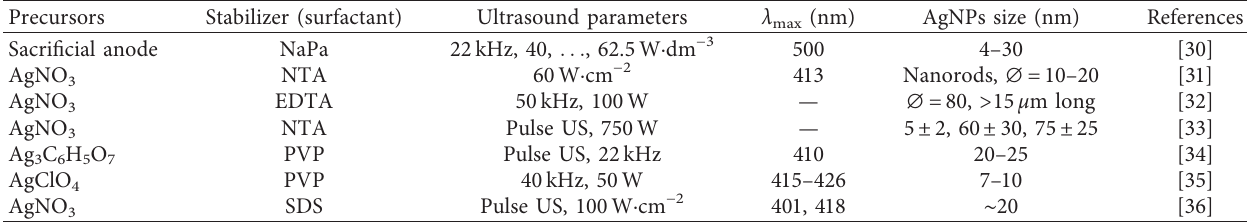
Table 1: Conditions for the sonoelectrochemical synthesis of silver